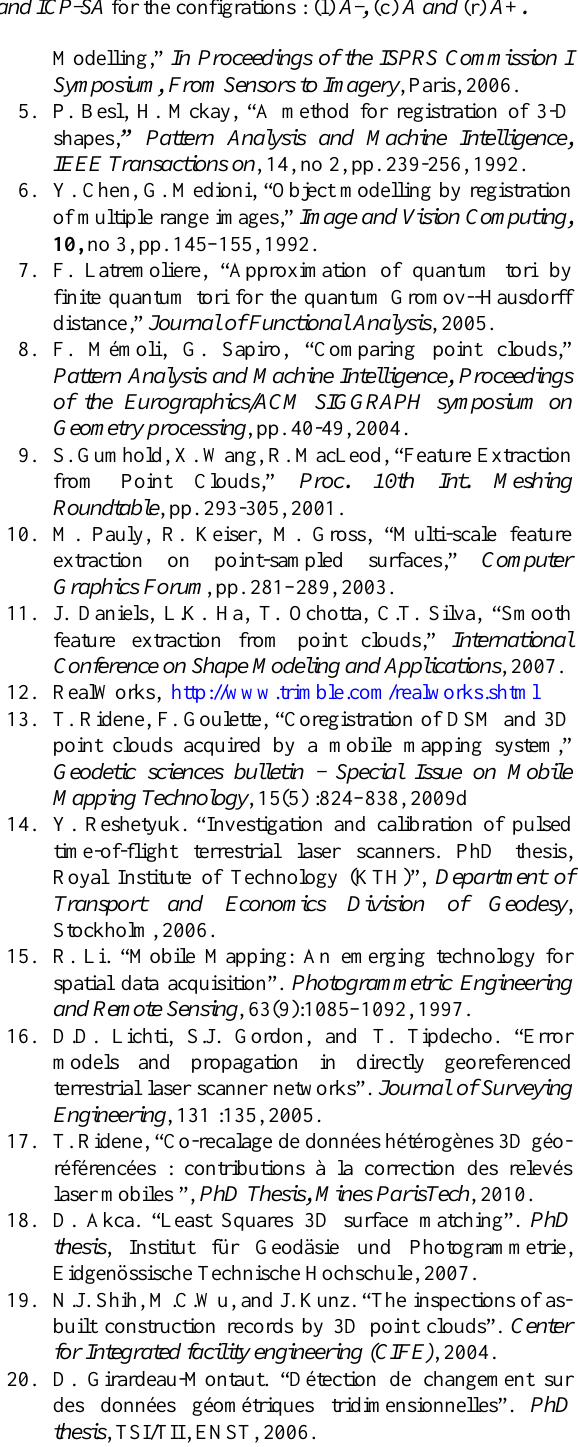
Fig. 11. “Soufflot Street”. Score of FBQ- E f for R-ICP , HPS-ICPand ICP-SA for the configrations : (l) A-, (c) A and (r) A+.